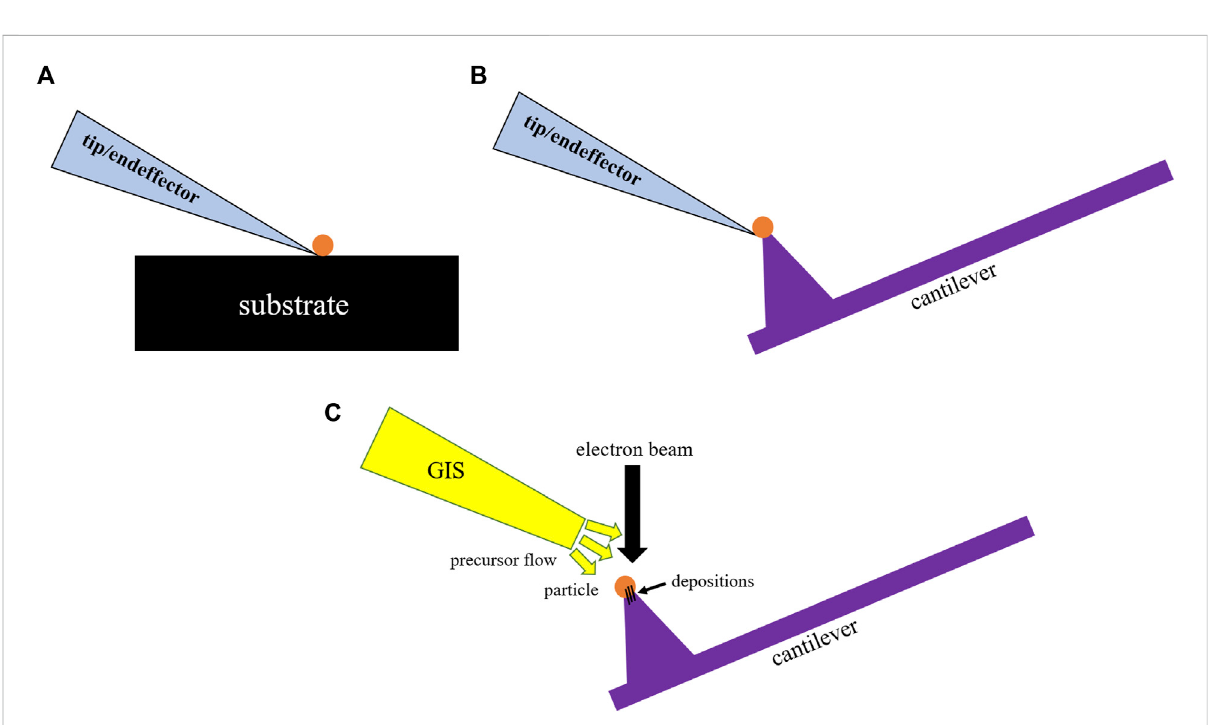
FIGURE 2 Illustration of the principle of a nanorobotically-assisted colloidal probe fabrication process; particle pick up in (A) , particle placement at the cantilever tip in (B) , and fastening of the particle via electron beam induced deposition (EBiD) in (C)